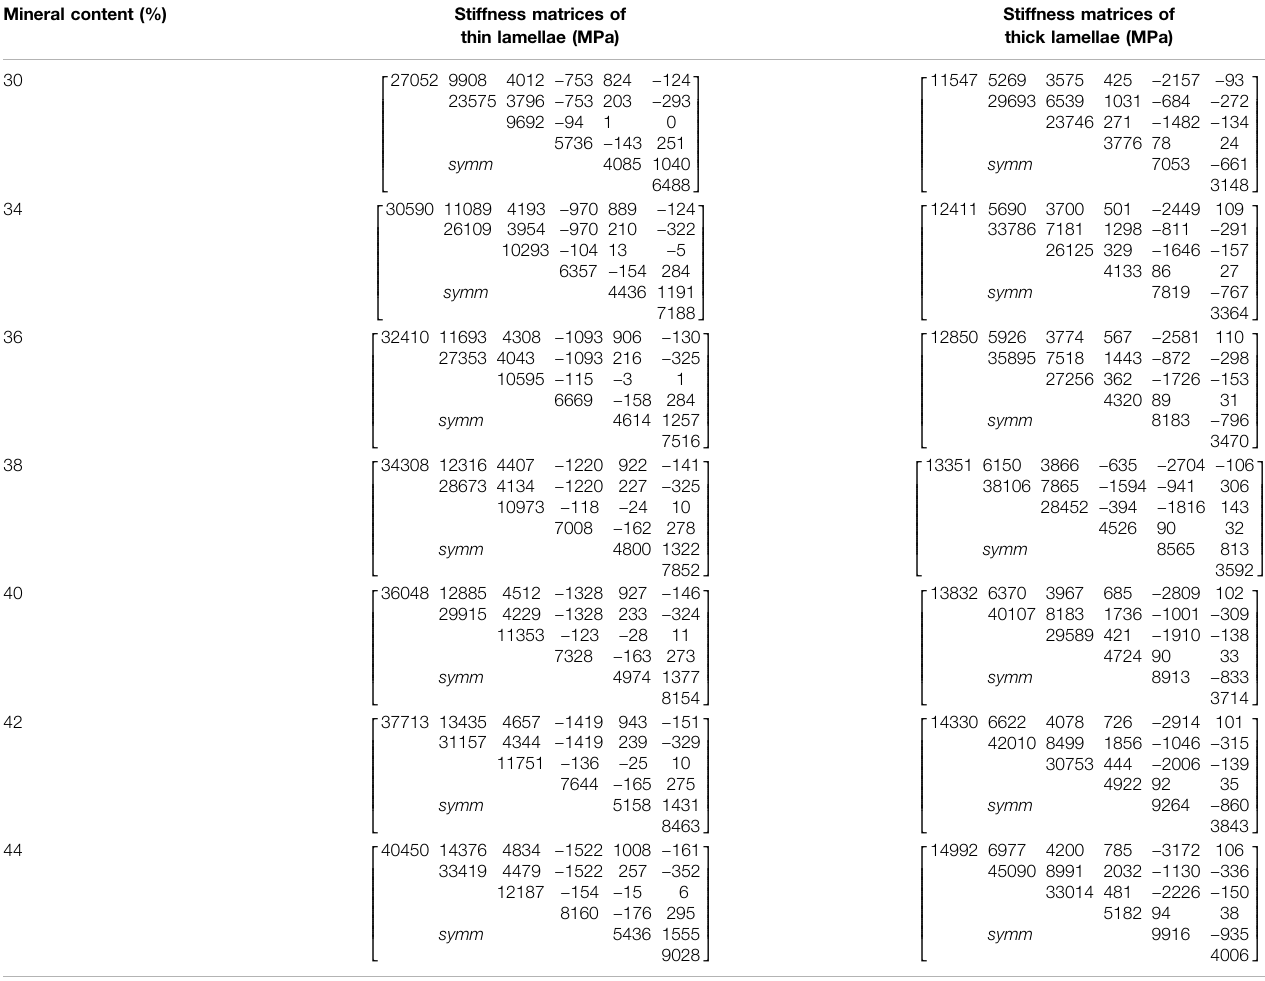
TABLE 5 | The stiffness matrices of thick and thin lamellae with different mineral contents. Mineral content (%) Stiffness matrices of thin lamellae (MPa)